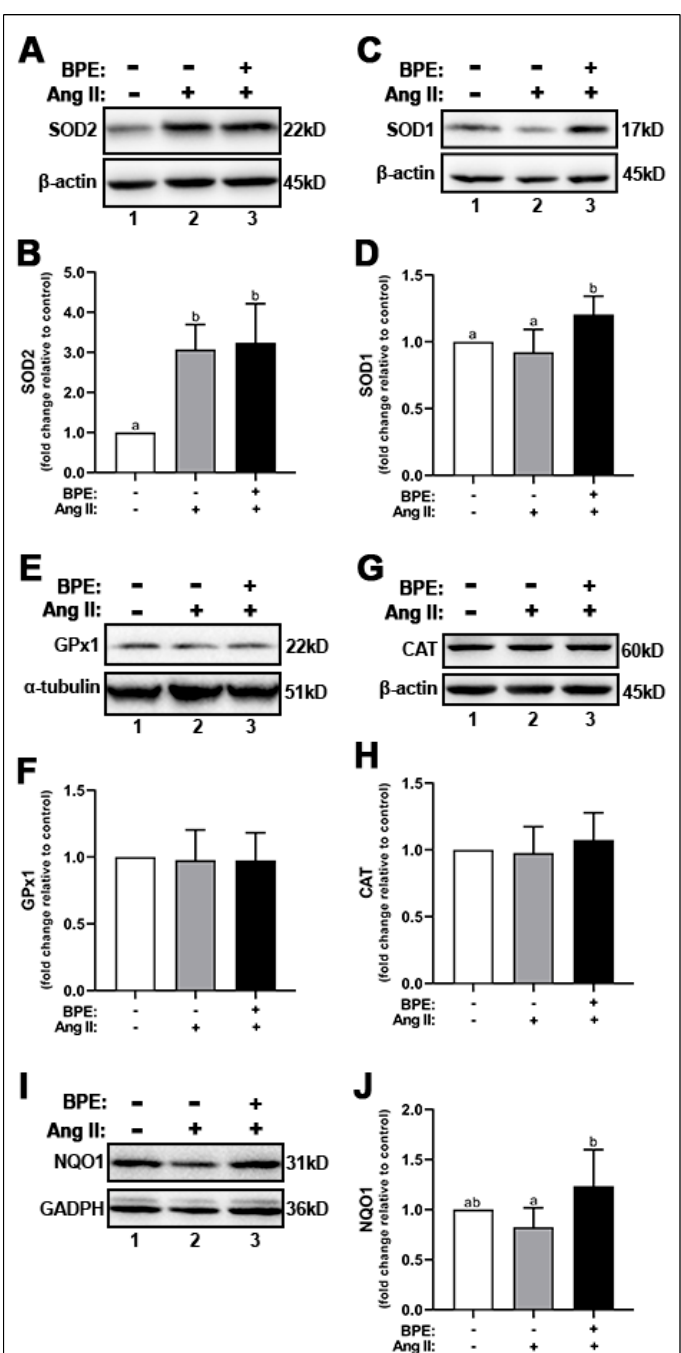
Figure 4. Blueberry polyphenol extract (BPE) increases the expression of antioxidant enzymes in angiotensin (Ang) II-treated human aortic endothelial cells (HAECs). HAECs were treated with 200 µg/mL of BPE for 1 h then treated with 200 nM of Ang II for 12 h. Protein expression of SOD2 ( A , B ), SOD1 ( C , D ), GPx1 ( E , F ), CAT ( G , H ), and NQO1 ( I , J ) were determined by Western blot. Quantification was performed using Image Lab (Bio-Rad Laboratories, Inc.). Data are expressed as mean ± SD from seven (SOD1, SOD2, and GPx1) four (CAT) and six (NQO1) independent experiments. Values that do not share the same letter are significantly different from each other ( p ≤ 0.05).